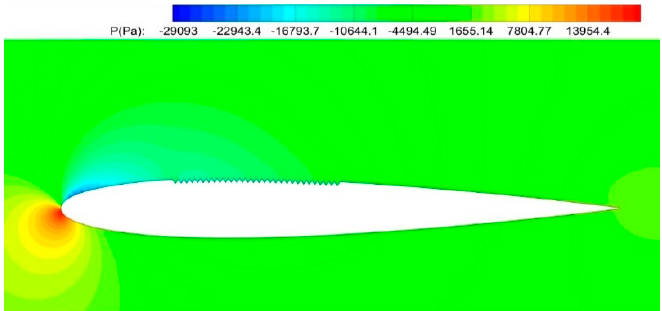
Figure 14. 4° angle of attack, speed distribution of grooves on the pressure side. Figure 14. 4 angle of attack, speed distribution of grooves on the pressure side.